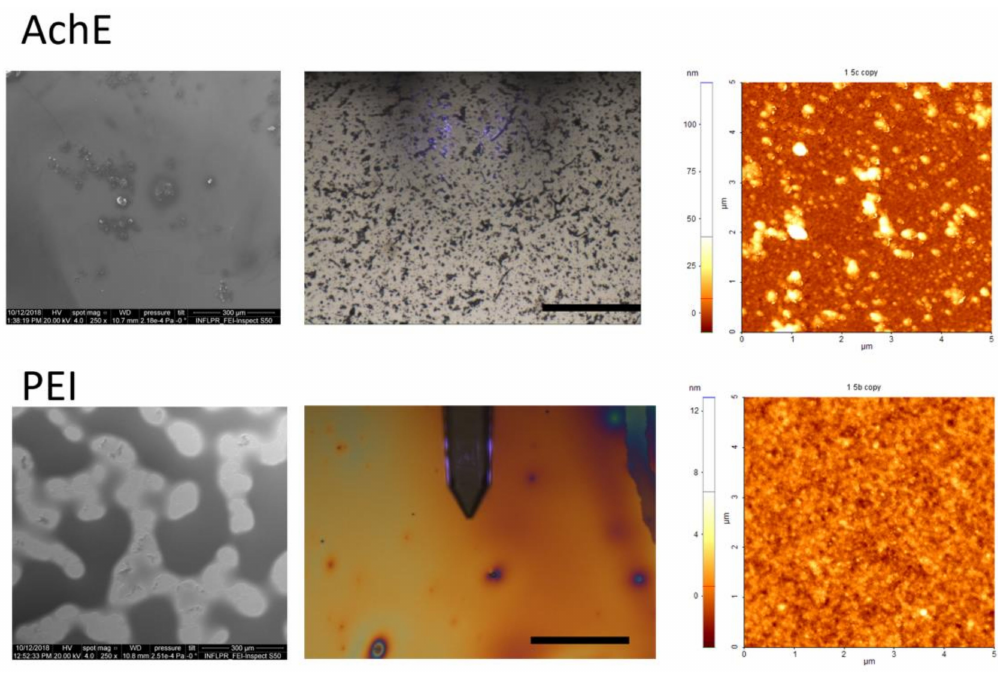
Figure 2. SEM, optical microscopy, and atomic force microscopy (AFM) images of AchE and PEI drop-casted materials.